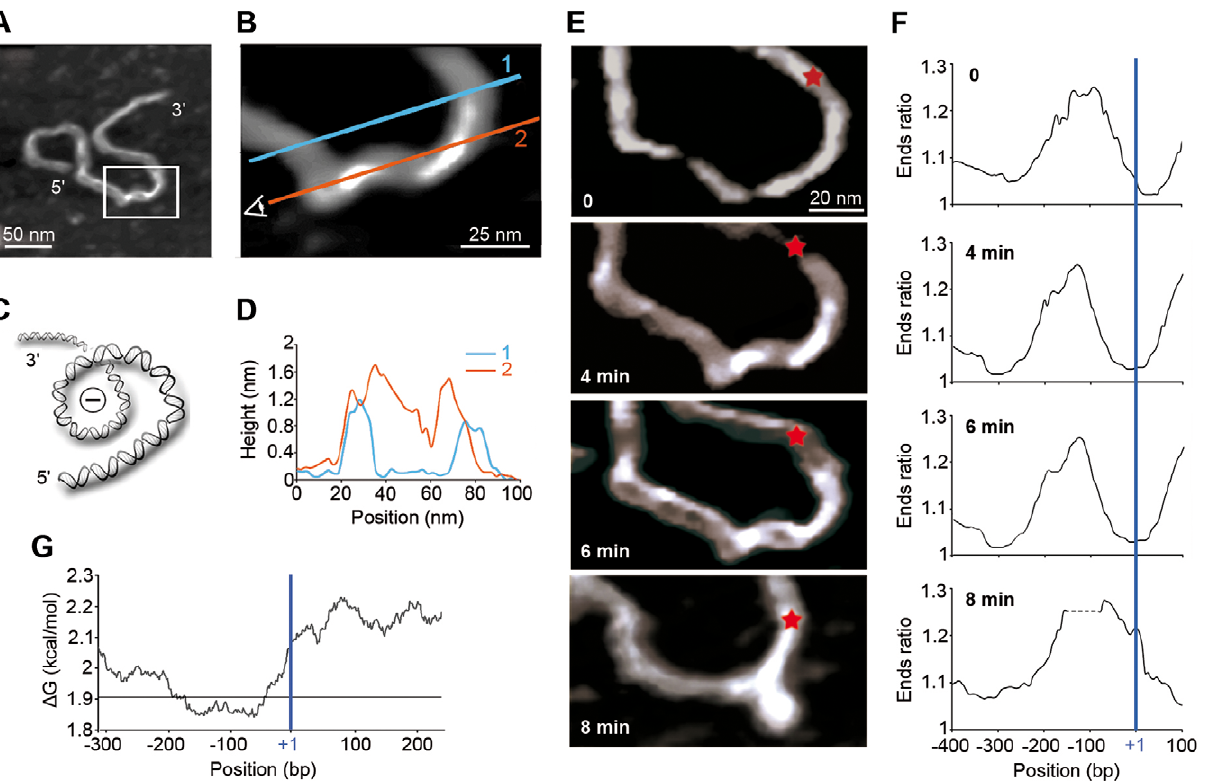
Figure 2. AFM imaging of the IL2RA gene promoter. (A) AFM image of the 1290 bp IL2RA fragment presenting a supercoiled structure. (B) Zoom on the region containing the supercoil, in the white rectangle in panel (A). Grey coding of topographic variations allows the visualization of the 3D shape of the structure. Sections 1 (blue line) and 2 (red line) correspond to the height measurements displayed in panel (D). (C) Schematic drawing of the negative supercoiled structure observed along the red vision axis 2 in panel (b). (D) Height measurements along the red and blue lines in panel (B). The supercoil summits are over 1.5 nm, whereas the double helix height in liquid ranges between 0.8 and 1.2 nm. (E) Time lapse AFM images of this fragment in the enlarged white box in (A) at 0, 4 min, 6 min and 8 min after beginning the observation. The position of the TSS is indicated by a red star. At 4 min, a negative supercoil was observed. A loop was formed out of the supercoiled region after 8 min. (F) Corresponding curvature profiles, expressed as Ends ratios (Materials and Methods), along the fragment (window 150 bp, step 1 bp). The position of the TSS ( + 1) is indicated by a vertical blue line. (G) D G variation profile along the 1290 bp IL2RA fragment. The horizontal line is the mean D G value over the whole gene sequence. Figure S1A). When TBP and TFIIB were incubated with the IL2RA promoter, we detected a (upper) band corresponding to the TBP-TFIIB-IL2RA complex (lane 3). A similar but less intense band was also detected without TFIIB (lane 2) as the signature of the less stable TBP-DNA complex. However, this band disappeared when TBP was not added to the reaction mixture (lane 4), thereby confirming that TFIIB cannot specifically bind to DNA without the presence of TBP. We corroborated the high affinity of IL2RA promoter for GTF binding by visualizing, by AFM, the binding of TBP-TFIIB TFs on the 563 bp IL2RA fragment (Figure 3B, right panels). From the analysis of N=50 oriented DNA molecules loaded by TBP-TFIIB GTFs, we found that these factors preferentially bind to the putative functional TATA box (Figure 3B, left panel). The fact that the TATA box region corresponds to curved DNA was previously argued as favoring the binding of these TFs as the first step of PIC formation [40]. A similar observation was obtained with the longest 1290 bp IL2RA fragment (data not shown).